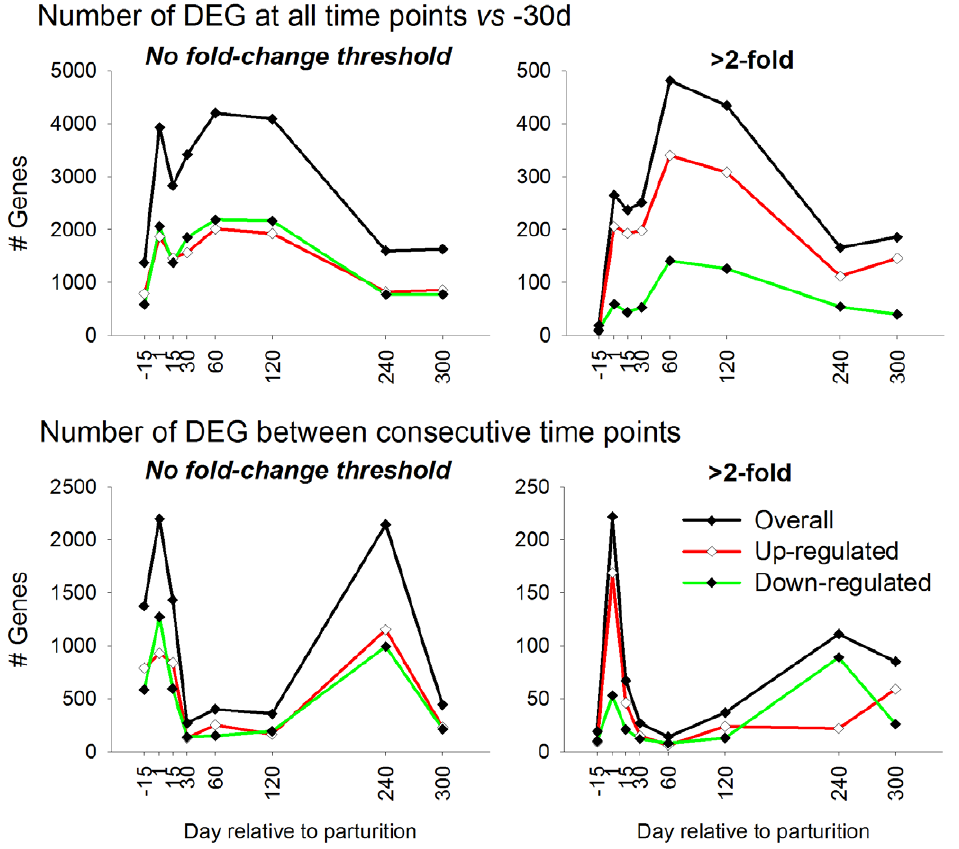
Figure 1. Number of differentially expressed genes with FDR # 0.001 and post-hoc P , 0.001 at each time relative to 2 30 d (pregnancy) (upper left panel), and relative to the previous time (bottom left panel). A 2-fold (100%)-change threshold was applied for both the panel encompassing each time relative to 2 30 d (pregnancy) (upper right panel) and the comparison of each time relative to the previous time point (bottom right panel). Applying such a threshold highlighted the increase in the proportion of up-regulated genes within DEG that were markedly affected. Additional images with several thresholds for each type of comparison are available in Figure S2).